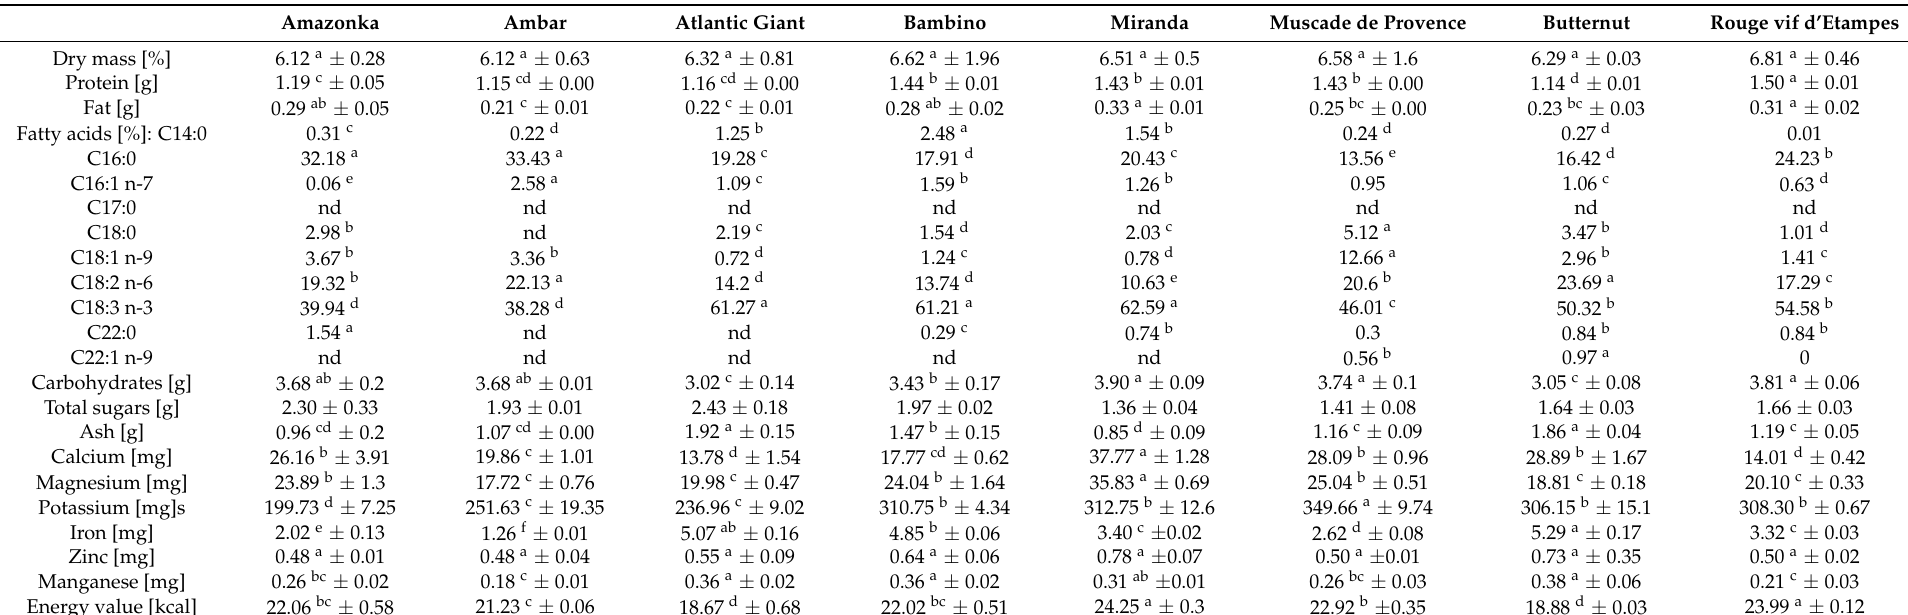
Table 1. Chemical composition of flowers of various species and varieties of pumpkins flowers (per 100 g of fresh weight). Amazonka Ambar Atlantic Giant Bambino Miranda Muscade de Provence Butternut Rouge vif d’Etampes